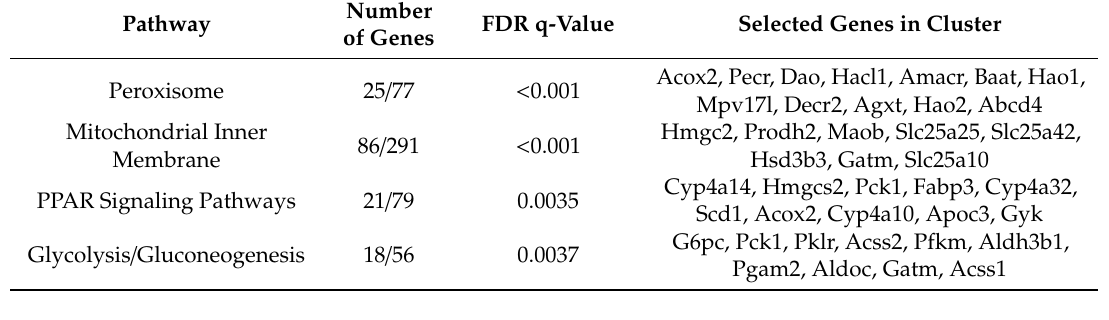
Table 2. Pathways of genes whose renal expression is higher in the TonEBP +/ ∆ mice compared to their TonEBP +/+ littermates after I / R treatment of kidneys. Microarray analyses were performed on RNA samples (n = 4) obtained from kidneys. Number of Genes denotes (number of genes whose expression was significantly higher in the TonEBP +/ ∆ mice) / (total number of genes in that particular pathway). FDR: false discovery rate. See text for details.